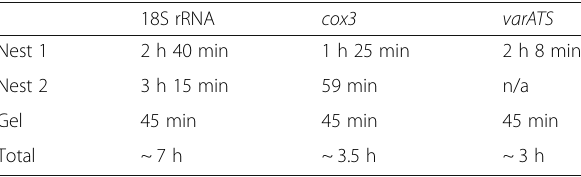
Table 3 Comparison of turnaround time for PCR and gel electrophoresis 18S rRNA cox3